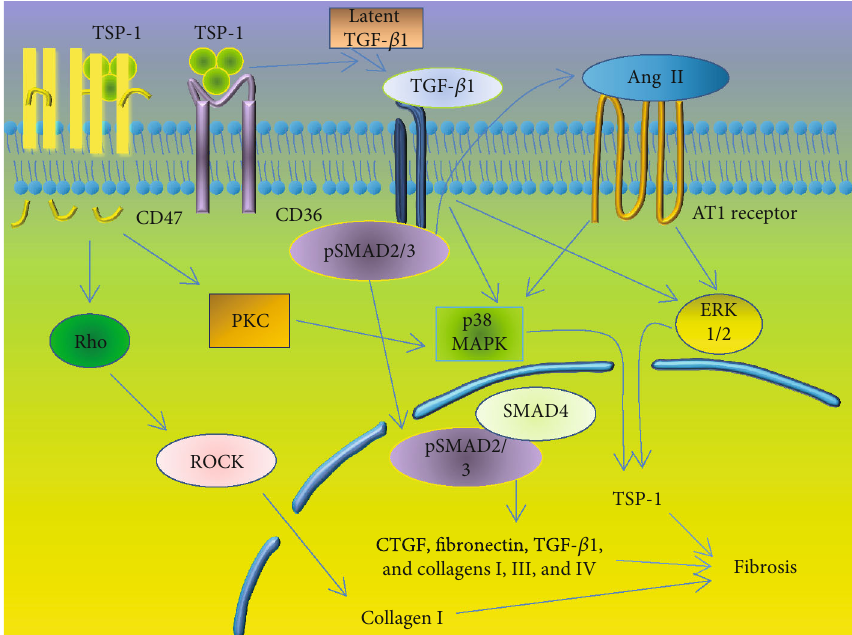
Figure 3: The progression of fi brosis caused by expression of ECM proteins after activation of TSP-1. After binding CD36, TSP-1 activates TGF- β 1 to initiate cellular fi brosis by triggering two distinct pathways that increase the quantity of expressed ECM proteins. One pathway involves Smad signaling. The receptor-regulated Smad2 and Smad3 are phosphorylated, leading to fi brosis. The other pathway involves non-Smad signals, including the ERK1/2 and MAPK p38 pathways. On the other hand, TSP-1 binding CD47 activates Rho-Rho kinase- (ROCK-) myosin and PCK pathways to enhance TSP-1 expression and TGF- β 1 activation, ultimately accelerating the progression of fi brosis. TSP-1: thrombospondin-1; PKC: protein kinase C; Ang II: angiotensin II; AT1: Ang II type 1; MAPK: mitogen-activated protein kinase; ROCK: Rho kinase; TGF- β 1: transforming growth factor β 1; and CTGF: connective tissue growth